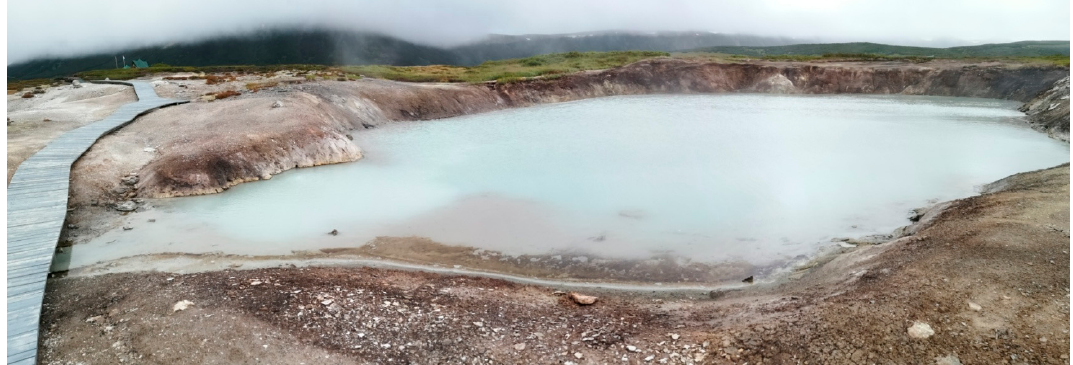
Figure A9. Bannoye Lake/Maar. Photo by A. Kiryukhin, 24 August 2019.